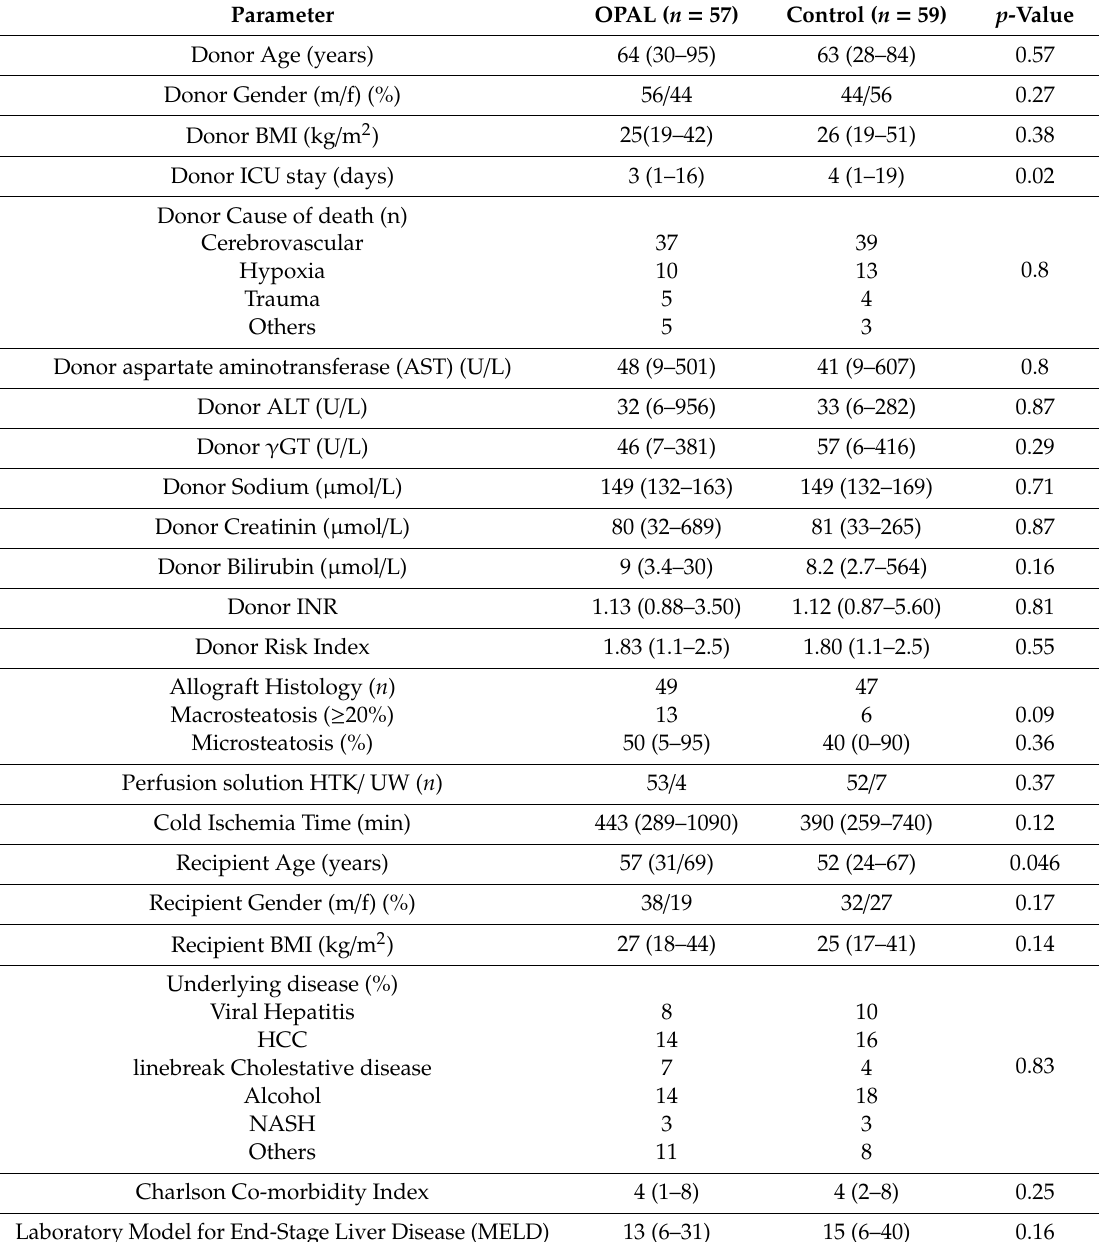
Table 1. Donor and recipient data; values given as median and range, where appropriate, in